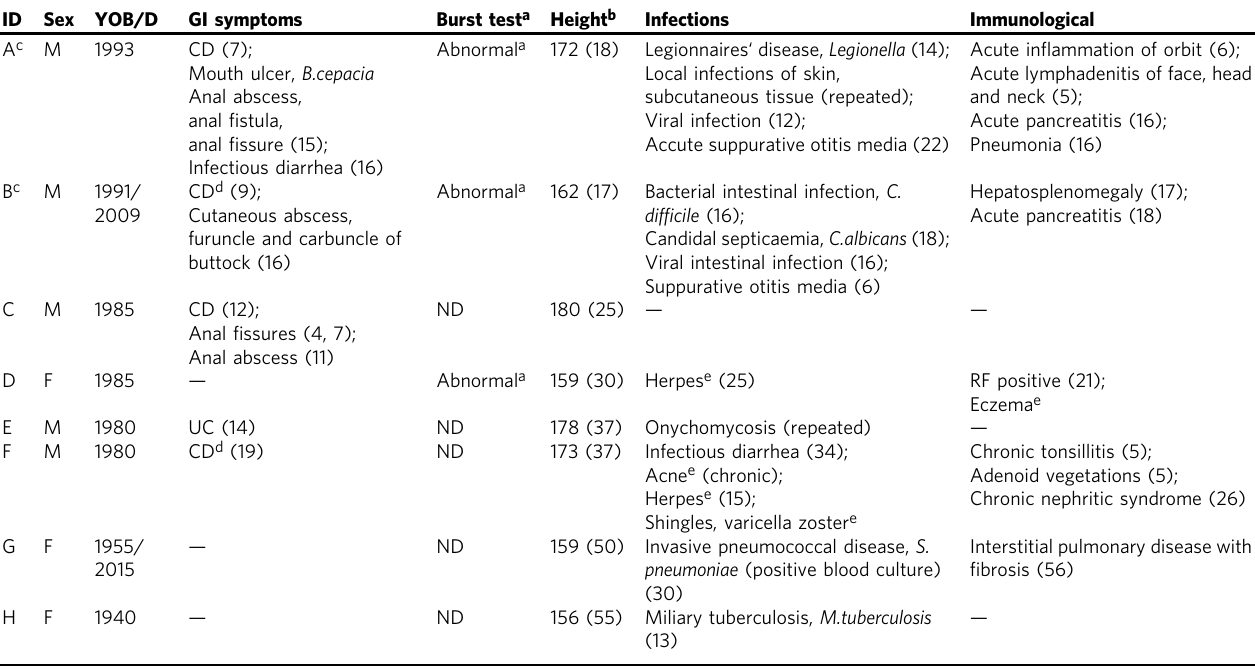
Figures in parentheses () denote age at diagnosis or measurement, in years YOB/D yearofbirth/death(roundedby5yearsforindividualsC – H), GI gastrointestinal, CD Crohn ’ sdisease, UC ulcerativecolitis, CGD chronicgranulomatousdisease, ND notdetermined, RF rheumatoid factor a Burst test for individual A and B was performed in 2008, burst test for individual D was performed in 2017 b All heights are given in cm. Average and SD for height of Icelandic males and females is 178.8±6.9cm and 165.6±6.3cm, respectively 35 c Individuals A and B are brothers, presented in Fig. 1 d Individuals B and F underwent total colectomy